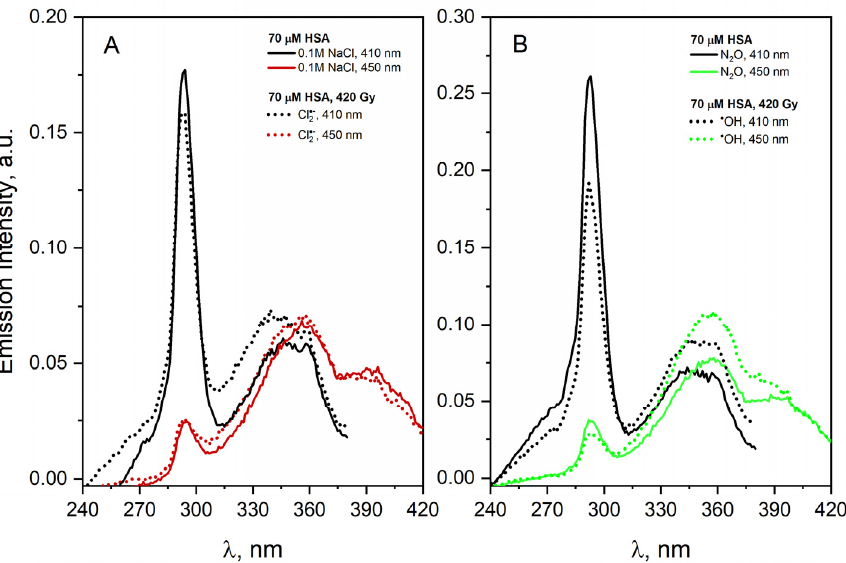
Figure 19. ( A ). Emission excitation spectra of the N 2 O-saturated HSA solutions (70 µM) containing 0.1 M NaCl recorded before and after irradiation with a dose 420 Gy. The emission detection wavelengths: 410 and 450 nm. ( B ). Emission excitation spectra of the N 2 O-saturated HSA solutions (70 µM) recorded before and after irradiation with a dose 420 Gy. The emission detection wavelengths: 410 and 450 nm.